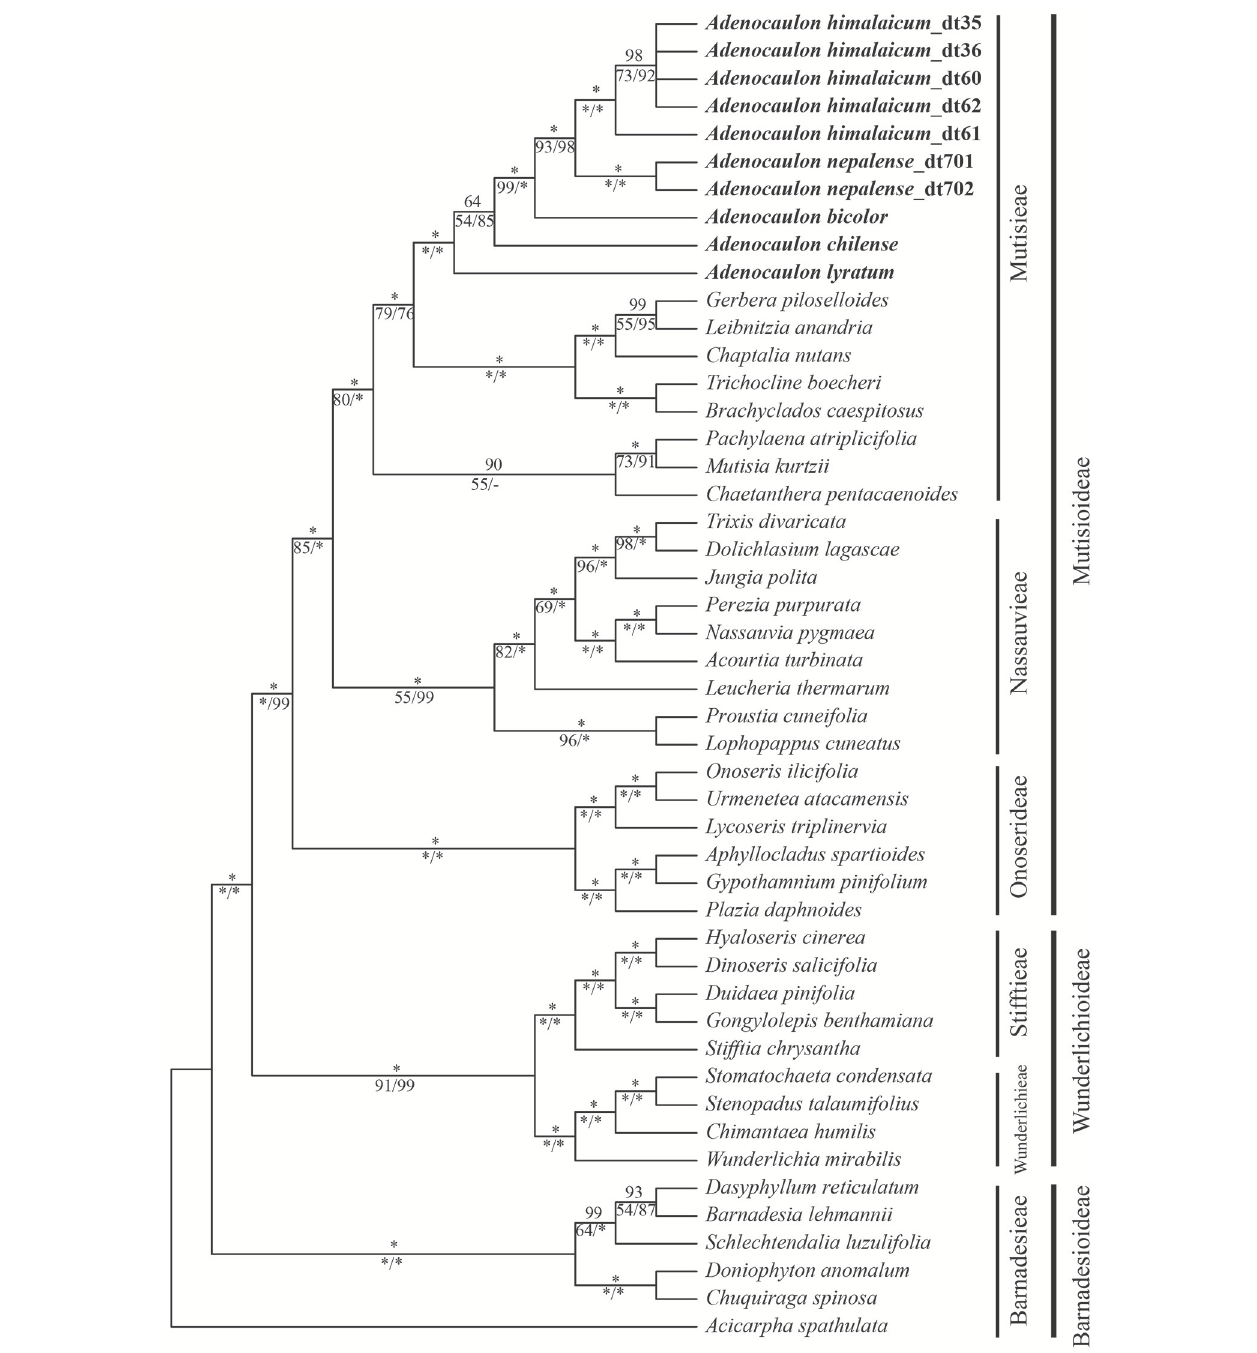
FIGURE 2 | Phylogeny of the basal grade of the Asteraceae, including Mutisioideae, Wunderlichioideae and Barnadesioideae, based on eight chloroplast DNA regions ( ndhF , matK , rpoB , rbcL , trnL-F , rpl 32- trn L, rpl 32- ndhF, and psbA - trnH ) and nuclear ITS. Numbers above the nodes are Bayesian posterior probabilities and below the nodes are bootstrap values obtained from MP analysis and posterior probabilities support values from ML analysis. “*” indicates full support for the respective analysis.